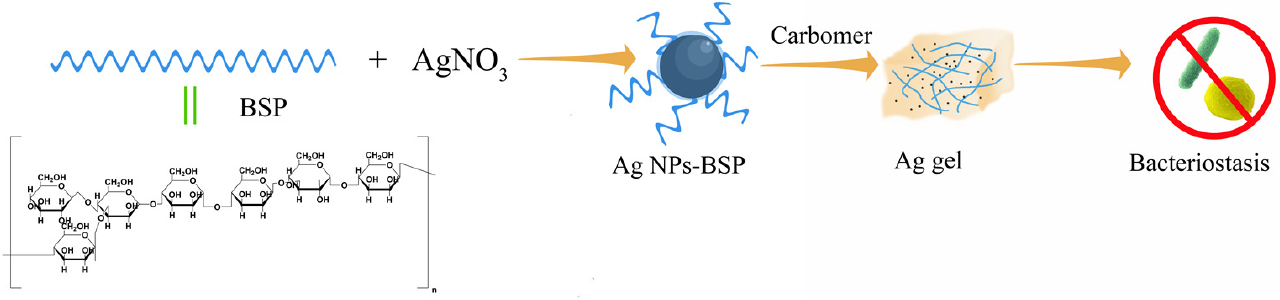
Figure 1. Schematic illustration of Ag NPs-BSP synthesis and verify antibacterial.